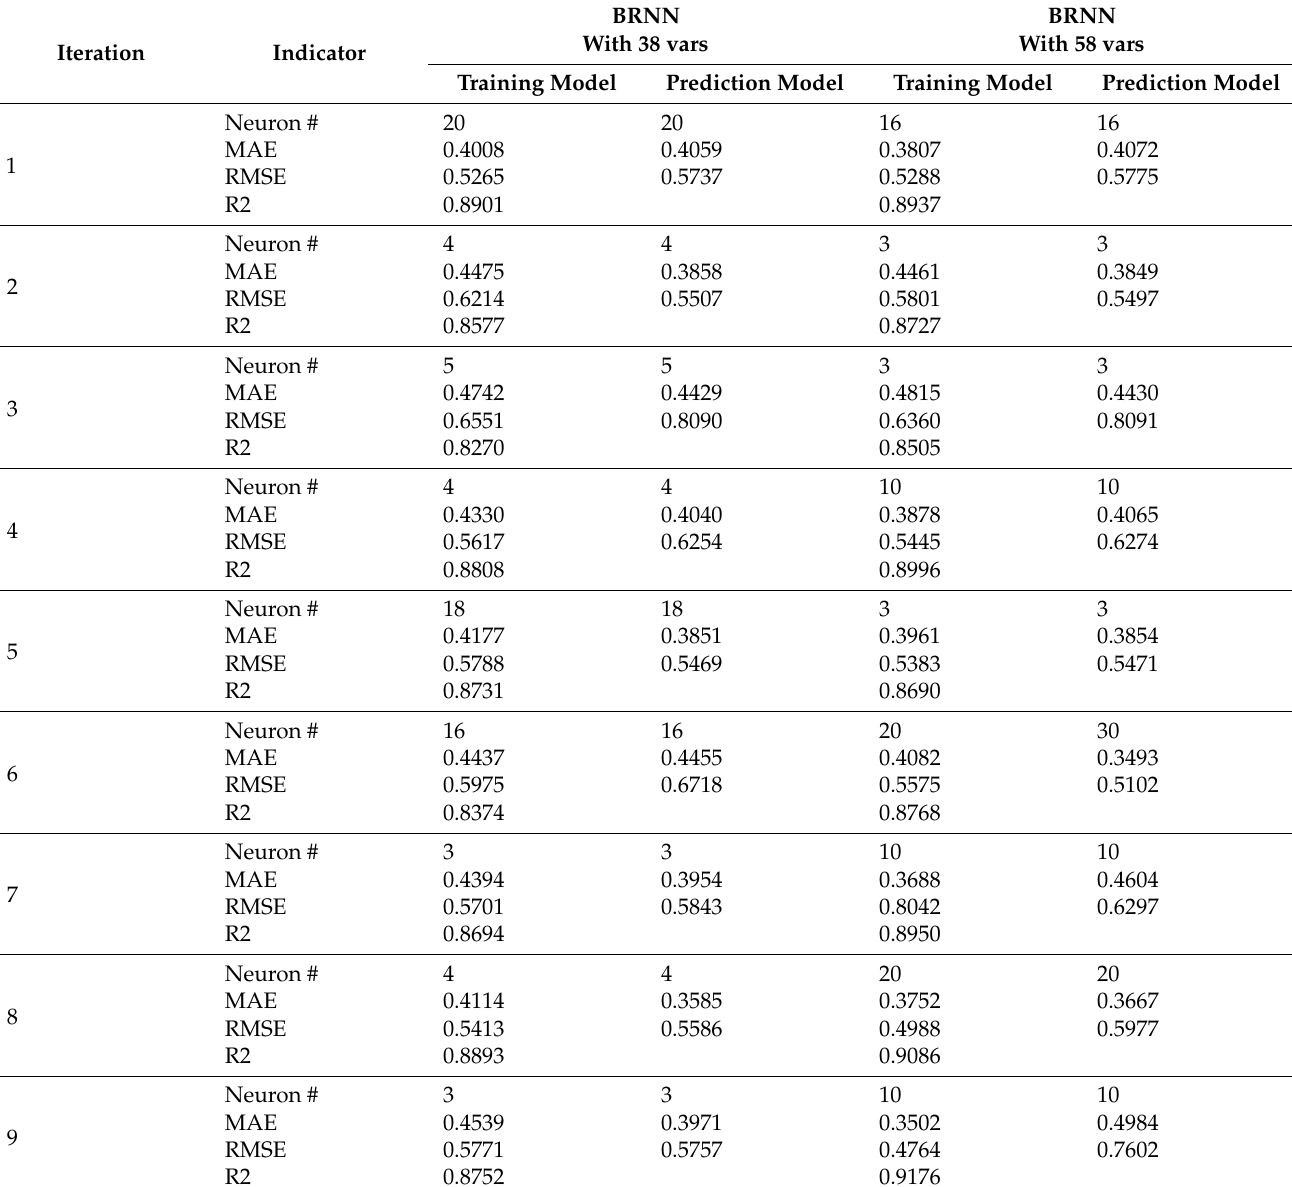
Table 2. Difference of Indicators between Training Model and Testing